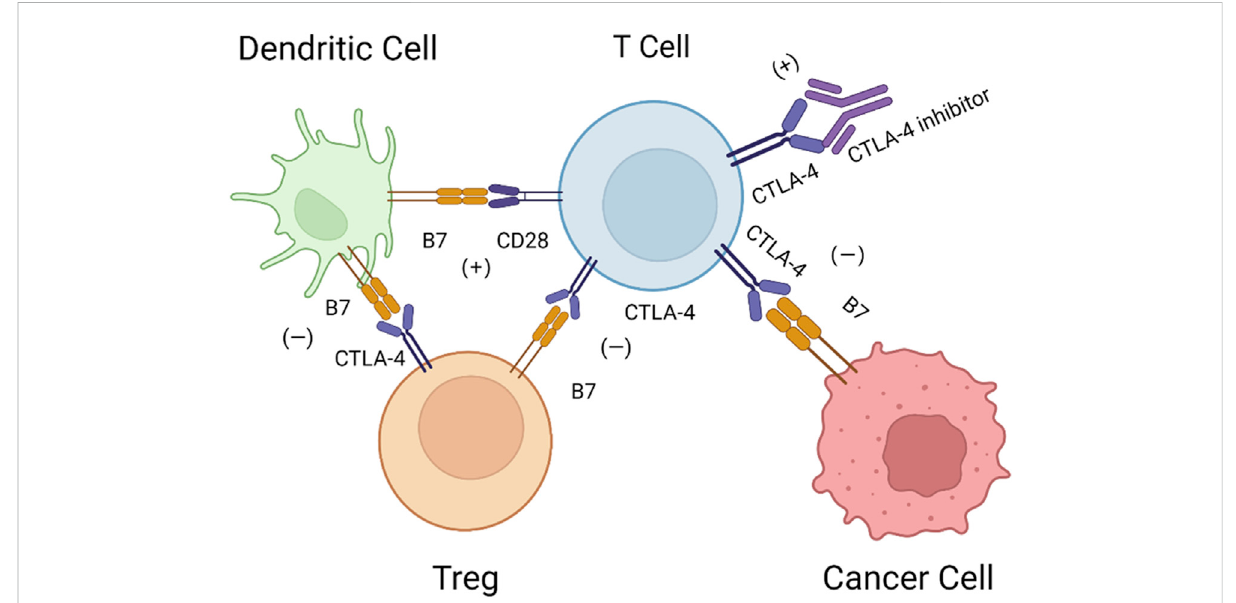
FIGURE 1 Mechanisms of CTLA-4. DCs activate T cells via B7-CD28, while CTLA-4 can bind with B7 on Tregs and cancer cells with higher af fi nity, and Tregs can inversely inhibit DCs via B7-CTLA-4. Therefore, CTLA-4 inhibitors may block this pathway to restore the activation of T